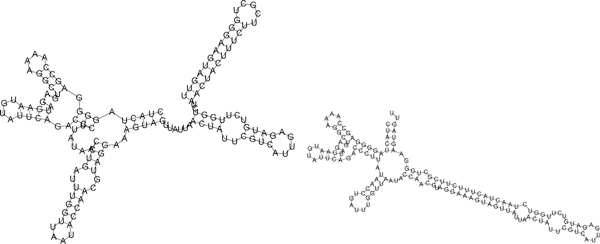
Sample outputs from RNAborMEAon a 143 nt TPP-riboswitch, AF269819/1811-1669 with sequence CUACUAGGGG AGCCAAAAGG CUGAGAUGAA UGUAUUCAGA CCCUUAUAAC CUGAUUUGGU UAAUACCAAC GUAGGAAAGU AGUUAUUAAC UAUUCGUCAU UGAGAUGUCU UGGUCUAACU ACUUUCUUCG CUGGGAAGUA GUU. We took the TPP riboswitch aptamer from the Rfam database [19], then extracted right-flanking nucleotides from the corresponding EMBL file, in order to include the expression platform. Displayed from left to right are the structures MEA(0) and MEA(61) (the structure MEA(52) is similar to that of MEA(61) and corresponds to a free energy local minimum in the left figure.) The structure MEA(61) had the highest MEA score over all structural neighbors, including the original structure S0 = MEA(0), and had free energy, -46.0 kcal/mol, that was equal to that of the initial structure S0 = MEA(0), which is the minimum free energy structure for the given sequence.